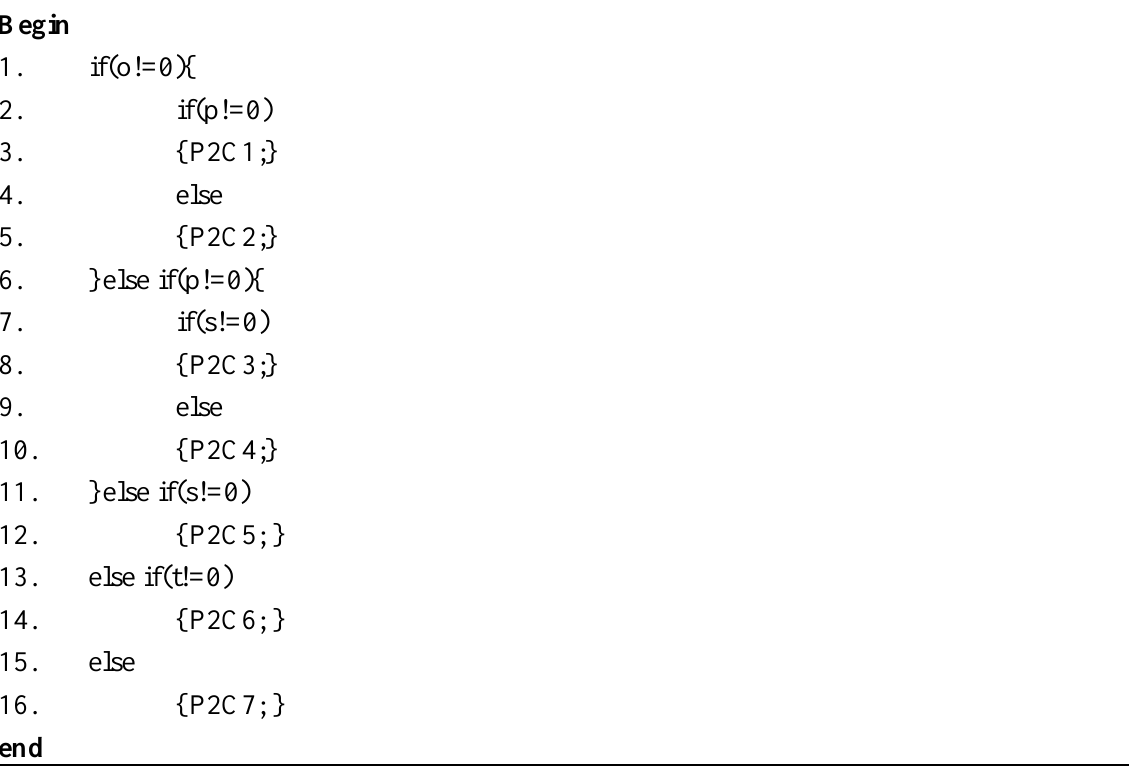
Algorithm 2 Procedure 2 of the First-Scan Method in the Proposed